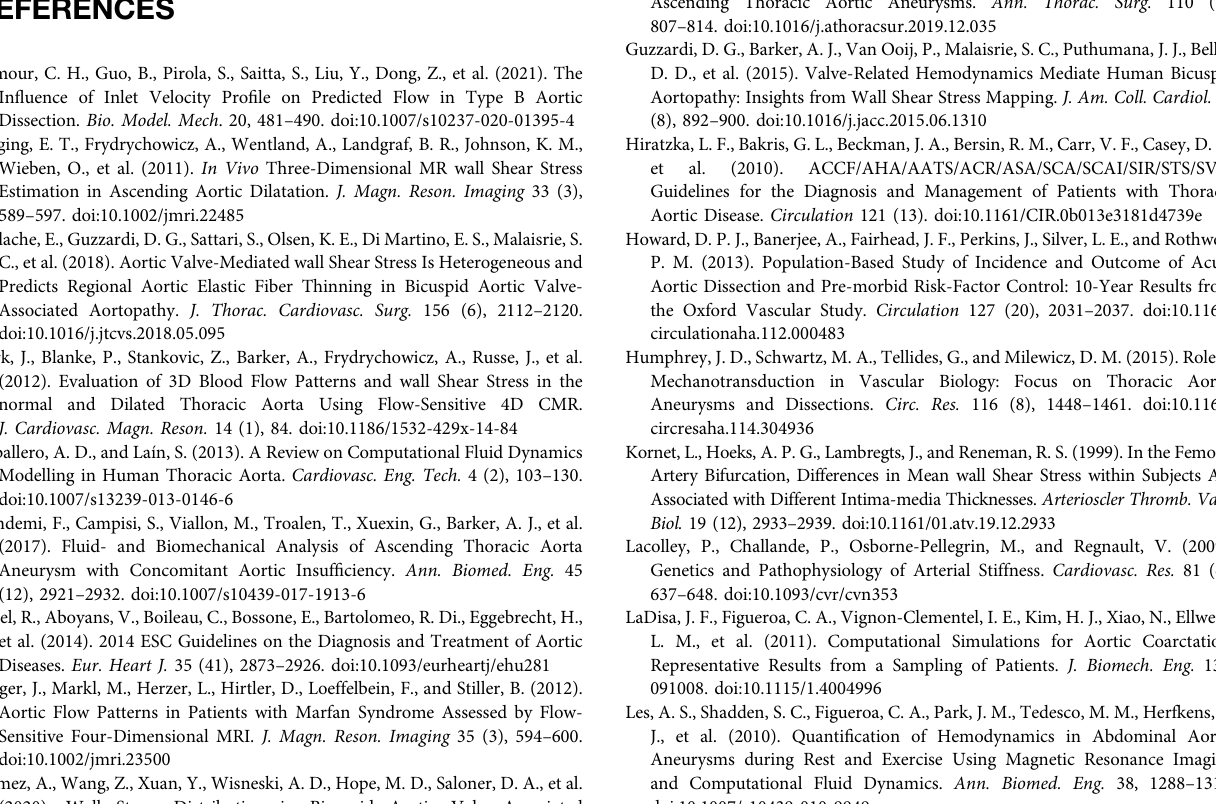
Supplementary Figure 1S | Example of unstructured mesh used for geometry discretization. The image shows details of the tetrahedral core and 10 prismatic layers at the wall (A) and of local mesh re fi nements. These were prescribed at the arch branches and the aneurysm wall, where a fi ner mesh was designed where higher velocity gradients were observed from 4D fl ow MRI data. Smooth transition between fi ner and coarser regions was ensured by prescribing small growth ratios and veri fi ed through mesh expansion factor (Ansys ICEM) (B)